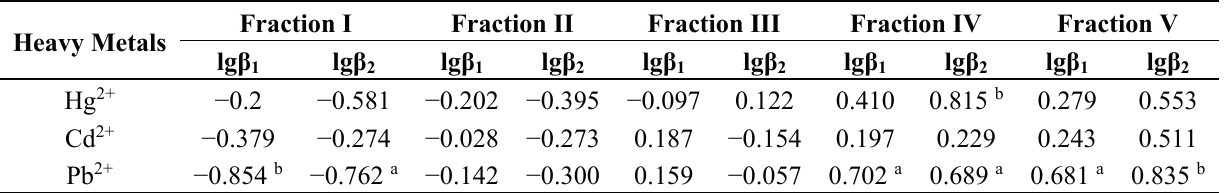
Table 5. Correlation coefficients between M w distribution and stability